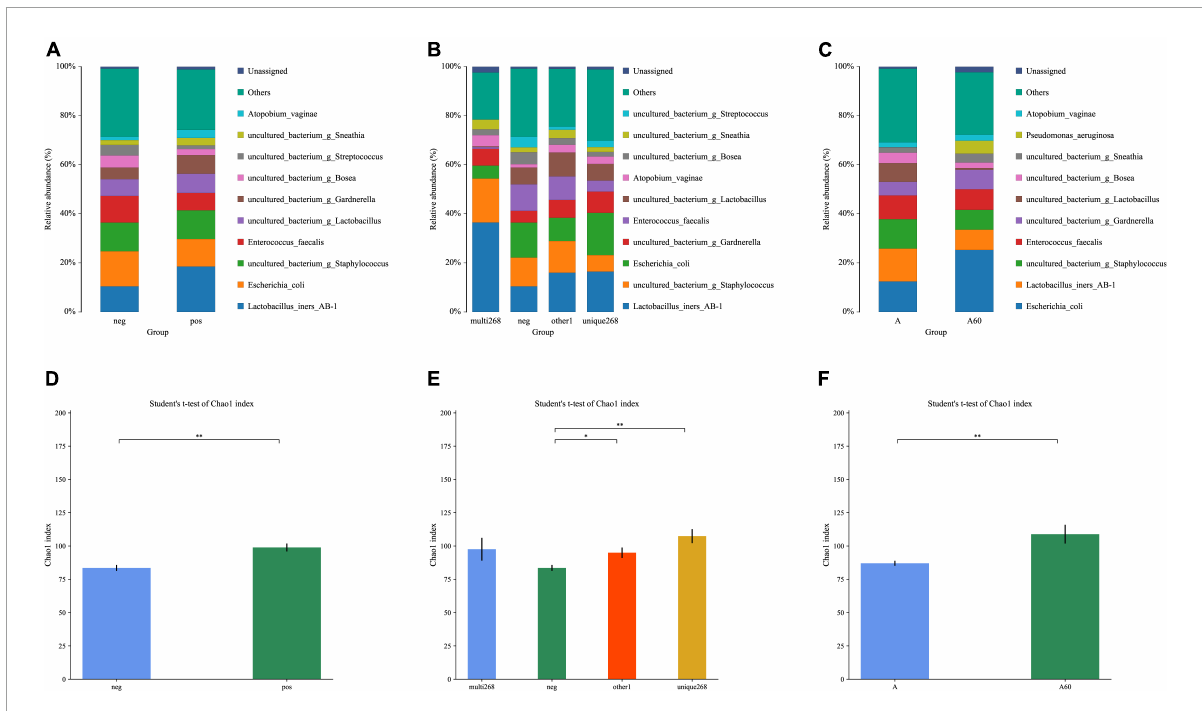
FIGURE1 Relative abundance and alpha-diversity analysis of this study. (A) Microbiota relative abundance distribution of HPV-positive and HPV-negative patient groups; (B) microbiota relative abundance distribution of HPV-positive unique-268 infection and multiple 268 infection, and HPV-negative patient groups; (C) microbiota relative abundance analysis of the elder (age > 60) and the younger (age ≤ 60) patient groups; alpha-diversity analysis; a-diversity comparison bar diagram, (D) Chao1 index for normal (without CIN) HPV-positive and HPV-negative patient groups, (E) Chao1 index for HPV-positive unique-268, and multiple 268 infections, HPV-negative patient groups, (F) Chao1 index for the elder (age > 60) and the younger (age ≤ 60) patient groups. neg: HPV-negative without CIN, pos: HPV-positive without CIN, multi-268: HPV 52, 56, and 58 genotypes multiple infection (regardless of CIN), unique268: HPV 52, 56, or 58 genotypes unique (single) infection (regardless of CIN), other1: other HPV infection situations (regardless of CIN). A: age under 60, A60: age above 60, ∗ p -value < 0.05, ∗∗ p -value < 0.01.